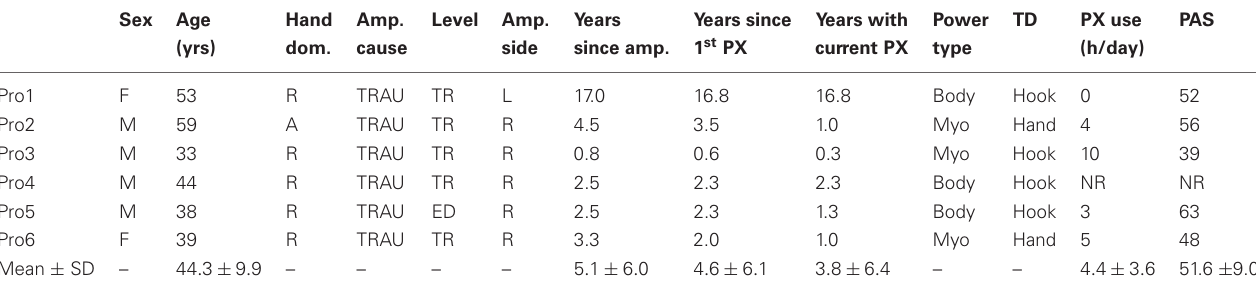
Table 1 | Demographic and clinically relevant information for the prosthesis users. Sex Age Hand Amp.